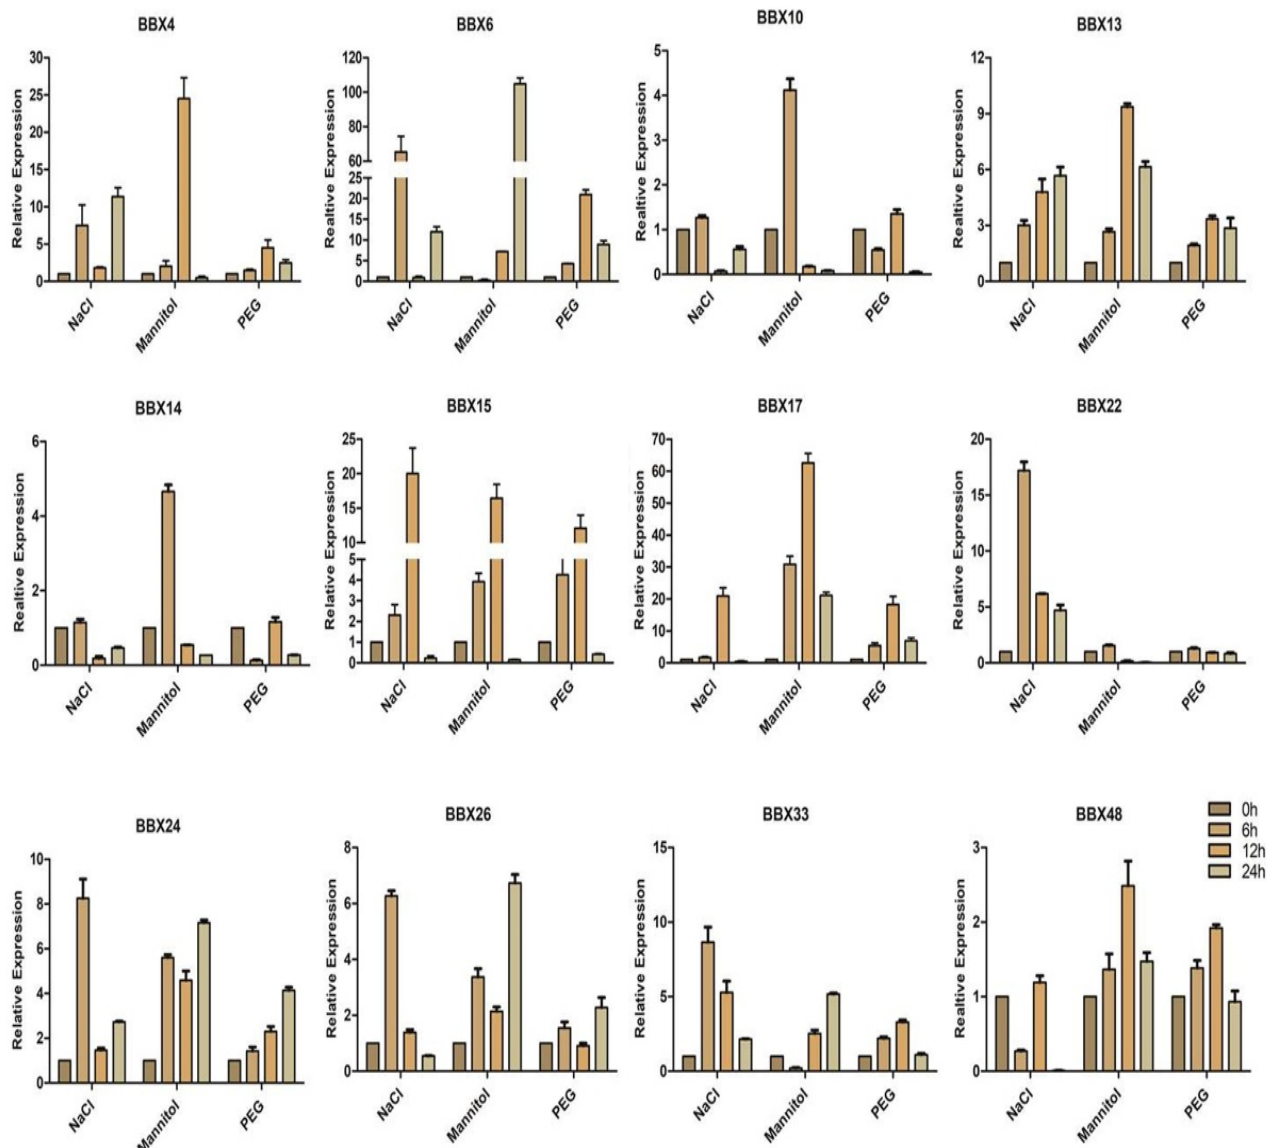
Figure 10. Abiotic stress-induced BrBBX expression profiles. The graphs present the expression levels in Brassica plants following NaCl, mannitol, and PEG treatments. Samples were collected at various time points for a qRT-PCR analysis. The x -axis presents the abiotic stresses. The y -axis presents the relative expression levels. Error bars indicate the standard deviations of three independent qRT-PCR biological replicates.